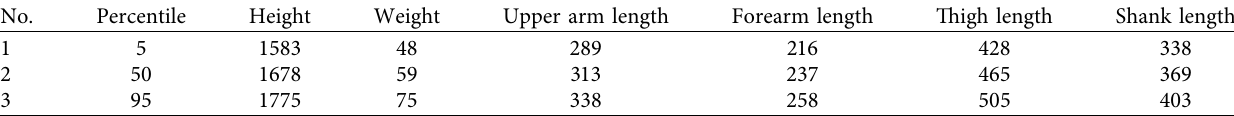
Table 2: Main dimensions of Chinese adult male human body (mm).